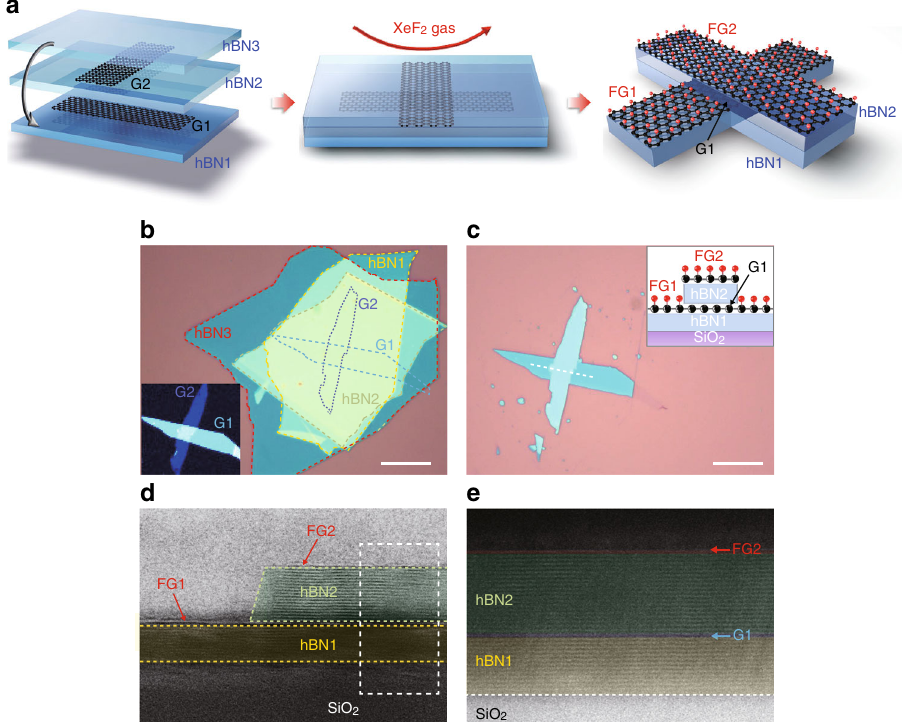
Fig. 1 Selective etching of a vdW heterostructure with XeF 2 gas. a Schematic of the XeF 2 etching process for a vdW heterostructure of stacked hBN and graphene layers. b , c Optical micrographs of a corresponding heterostructure fabricated from stacked exfoliated fl akes before and after exposure to XeF 2 . The scale bar is 10 μ m. Before etching, the heterostructure is composed (from bottom to top) of silicon oxide substrate, 5 nm hBN, 1 L graphene, 8 nm hBN, 1 L graphene, and 10 nm hBN. The inset in b shows a Raman map of the 2D graphene peak, indicating the positions of the two graphene layers (G1 and G2). c Optical micrograph of the sample after XeF 2 etching, with an inset illustration indicating the cross-sectional structure in the region indicated. The changes in color between b and c represent changes in fi lm thickness as determined by thin- fi lm interferometry. The substrate is brown, while the thinnest hBN is blue and increasing thickness, and the changes in color represent changes in the hBN thickness from dark blue (thinnest) to light blue to green to yellow (thickest). d False-color cross-sectional bright- fi eld STEM image of the etched heterostructure. The scale bar is 10 nm. The hBN layers (hBN1 and hBN2) covered with graphene masks (FG1 and FG2) were protected from XeF 2 etching. e Annular dark- fi eld STEM image taken from the white-dashed area of ( c ) shows atomically sharp and clear heterointerfaces. The scale bar is 5